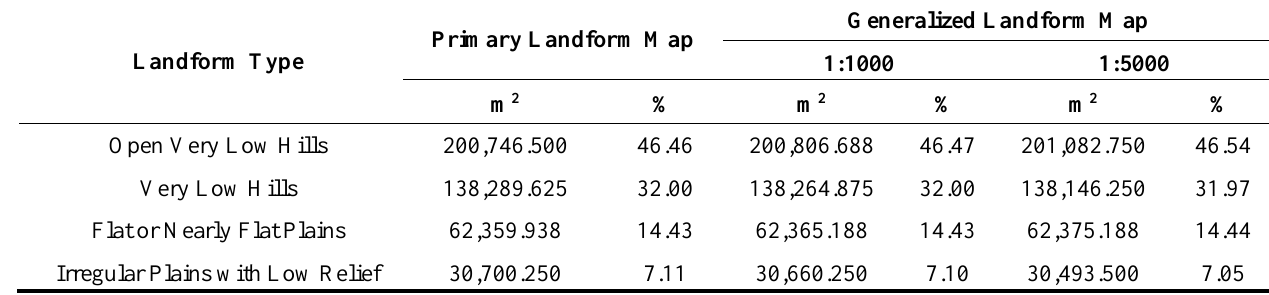
Table 3. Area and percentage of each landform type in primary, 1:1000 and 1:5000 landform